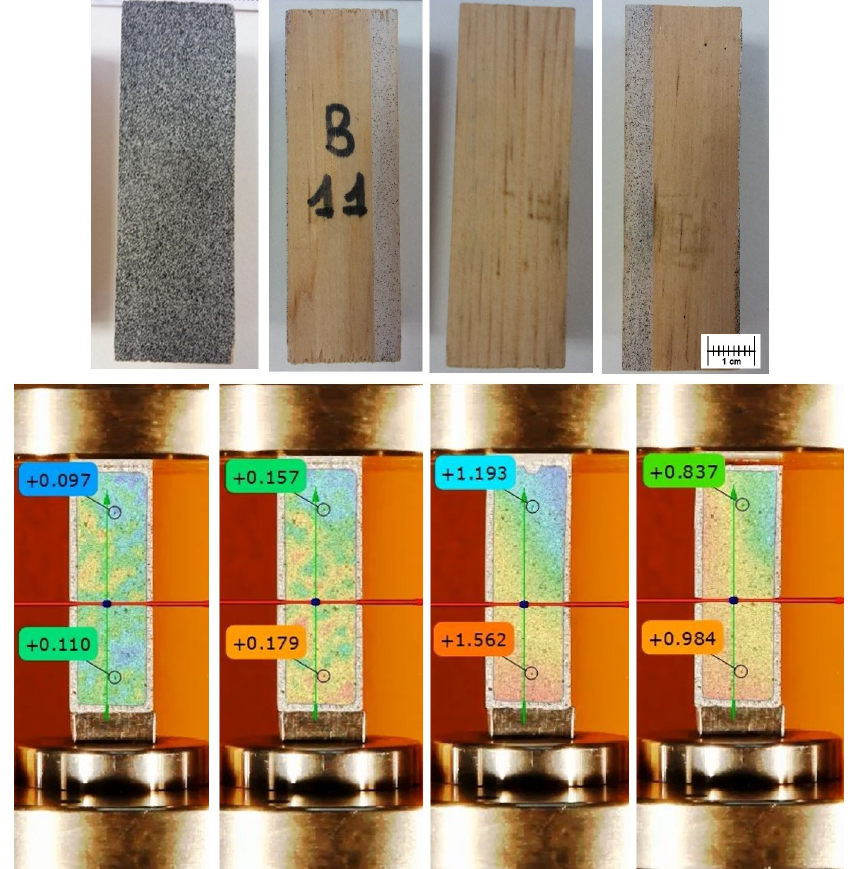
22 Figure 22. Final appearance of specimen B11 (all lateral faces). Frames of the test, in which the latter two show recovery in the elastic zone and separation from the